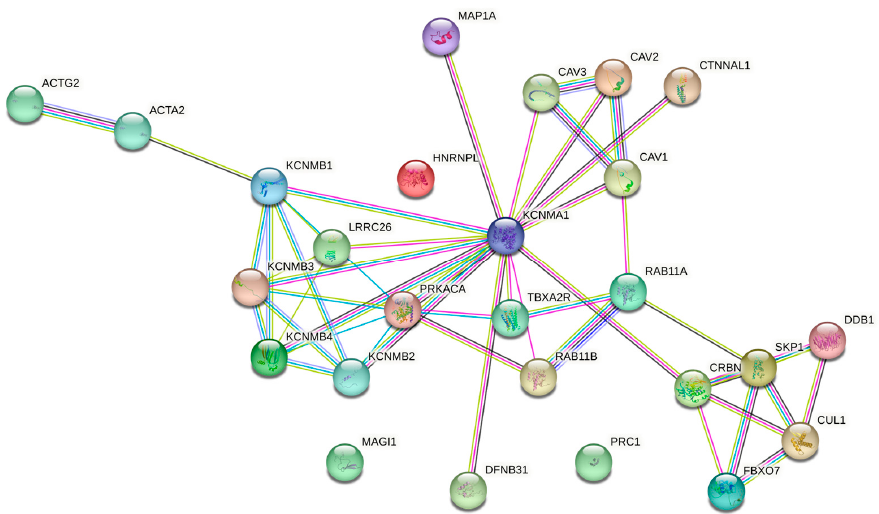
Figure 2. The STRING interaction network for KCNMA1, showing the top 25 interactants. Edge colours are as follows: known interactions: light blue, from curated databases; magenta, experimen ‐ tally determined; predicted interactions: green, gene neighbourhood; dark blue, gene co ‐ occurrence; others: lime, text ‐ mining; black, co ‐ expression; purple, protein homology.